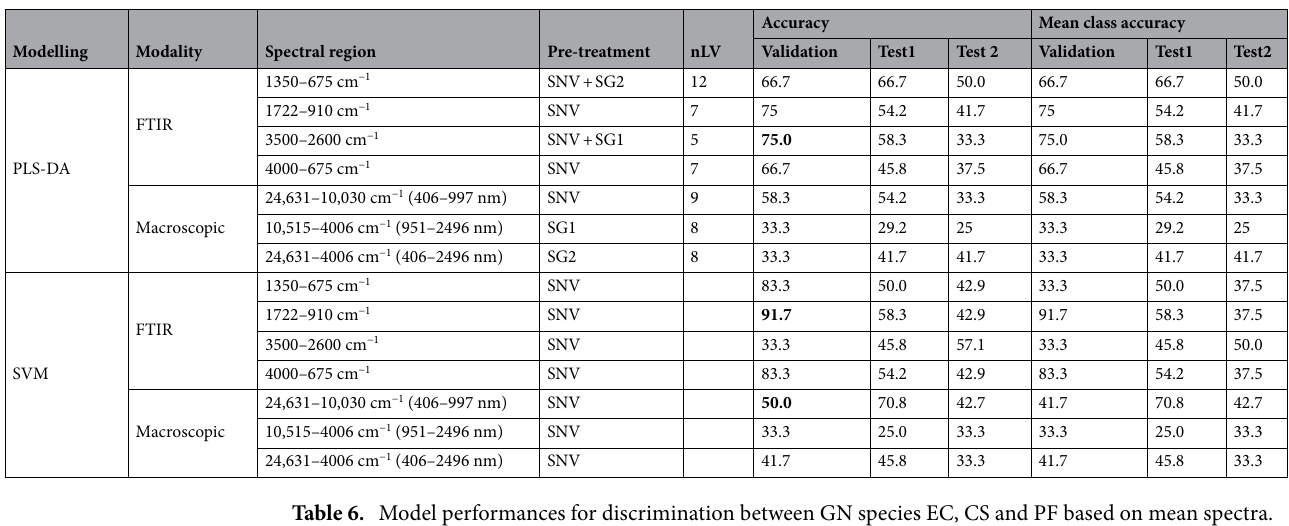
Table 6. Model performances for discrimination between GN species EC, CS and PF based on mean spectra. For each modality/spectral region, the model yielding maximum accuracy in the validation set is bolded.